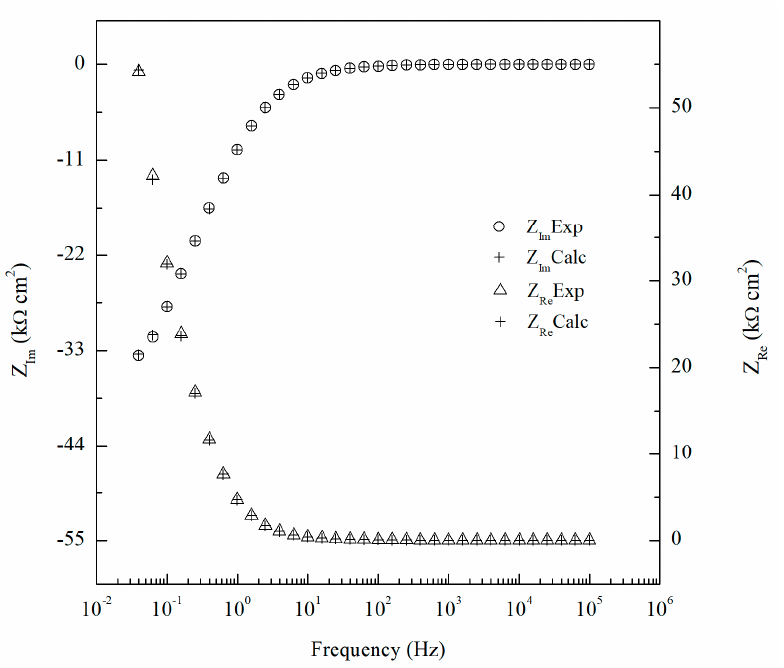
Figure 11. Comparison of experimental impedance data for 14 days sensitized specimen and calculated values using Kramers–Kronig (K–K) transformation for AA5083.